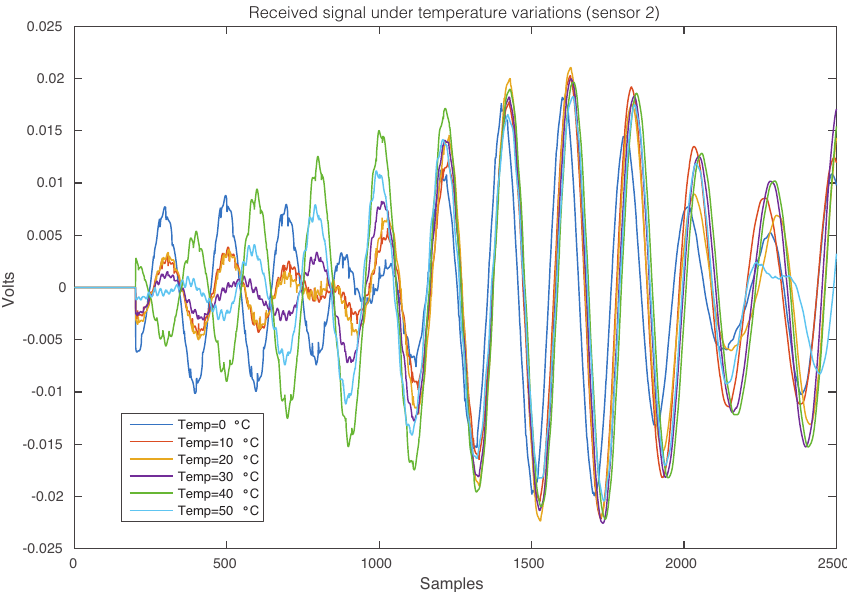
Figure 20. Signal that is received by Sensor 2 when the first sensor is used as an actuator.